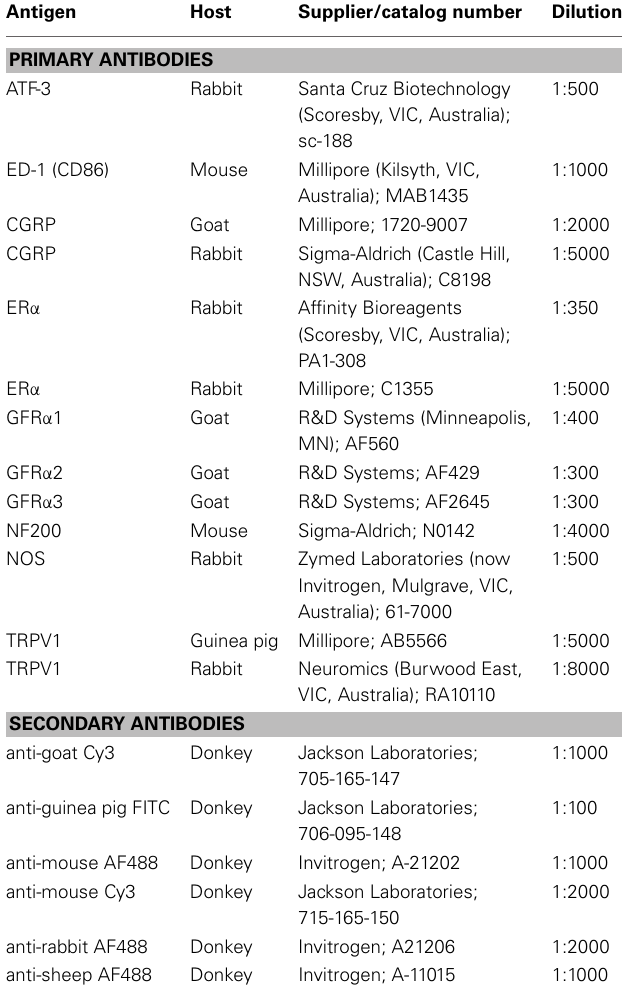
Table 1 | Primary and secondary antibodies used for